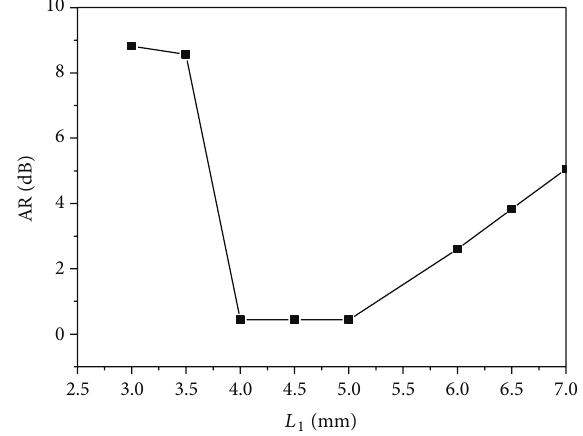
Figure 5: Axial ratio of the SIW leaky-wave antenna as function of length 𝐿 1 of the N-shaped slot for 𝑓 = 8 GHz, 𝐿 = 5 mm, 𝑊 = = 3.2 4.2 mm, and 𝑊 1